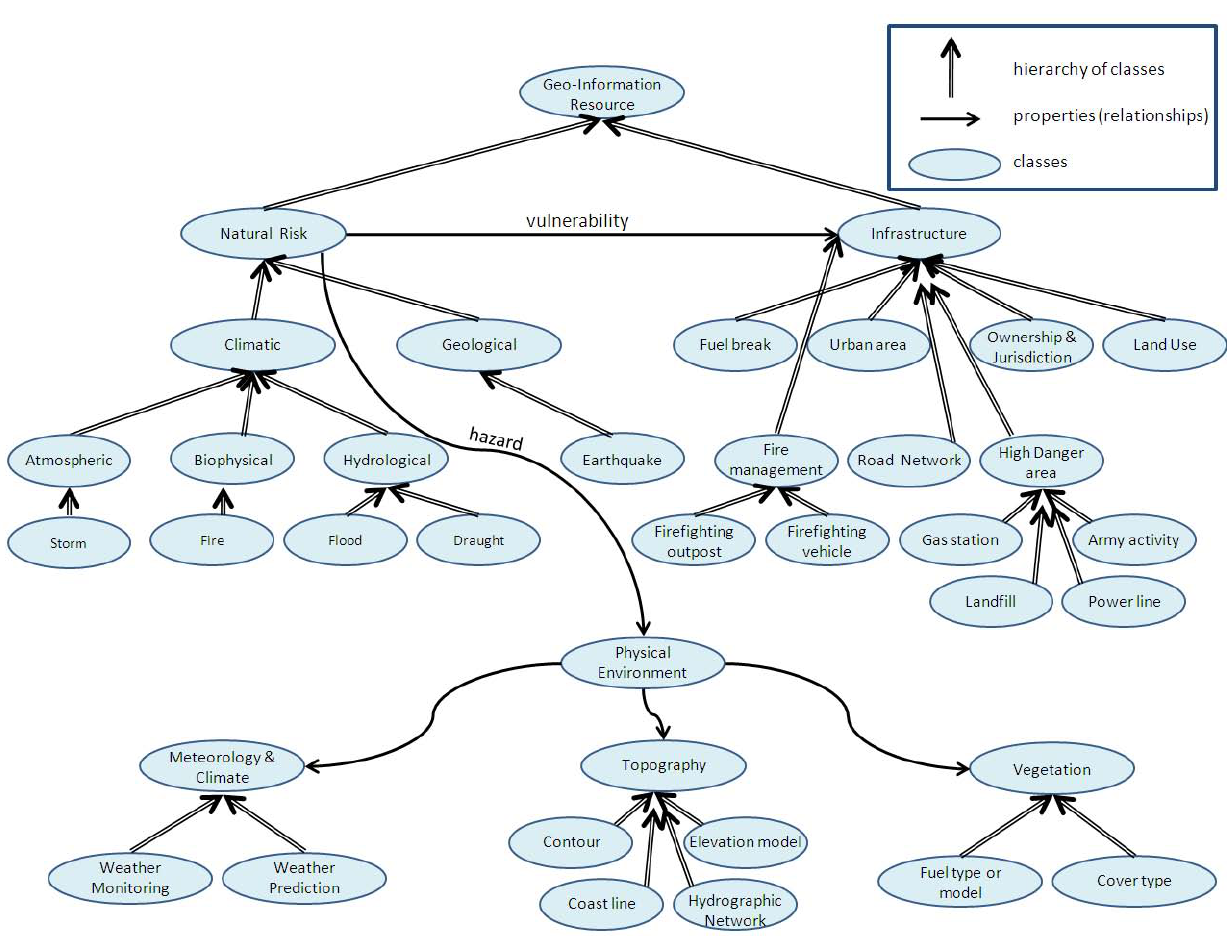
Fig. 3. The OntoFire